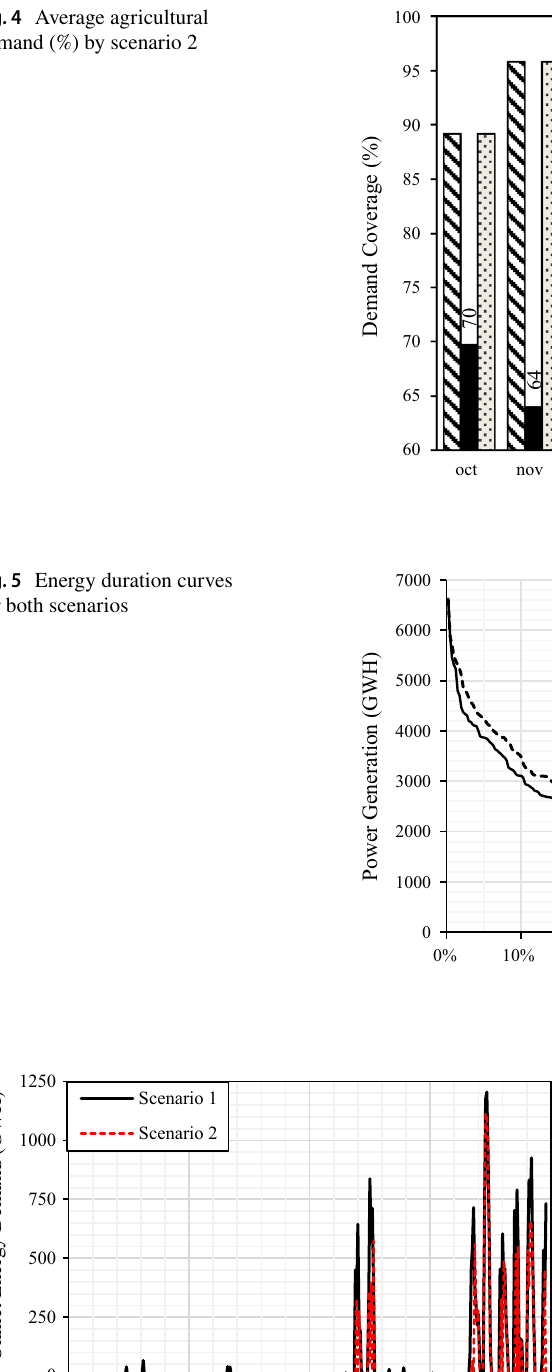
Fig. 4 Average agricultural demand (%) by scenario 2